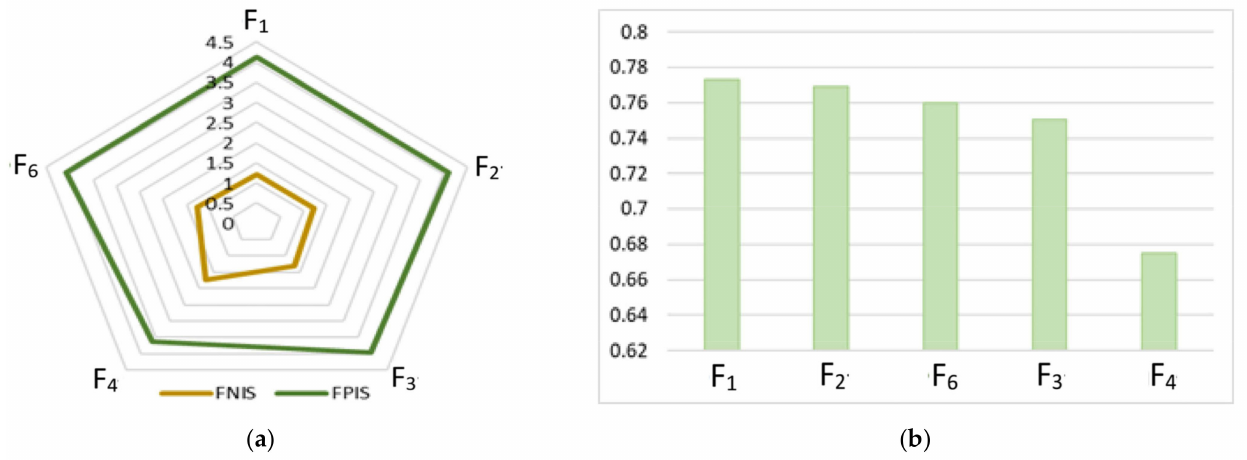
Figure 8. F-TOPSIS results: ( a ) FPIS and FNIS distance; ( b ) closeness ratio versus factor.